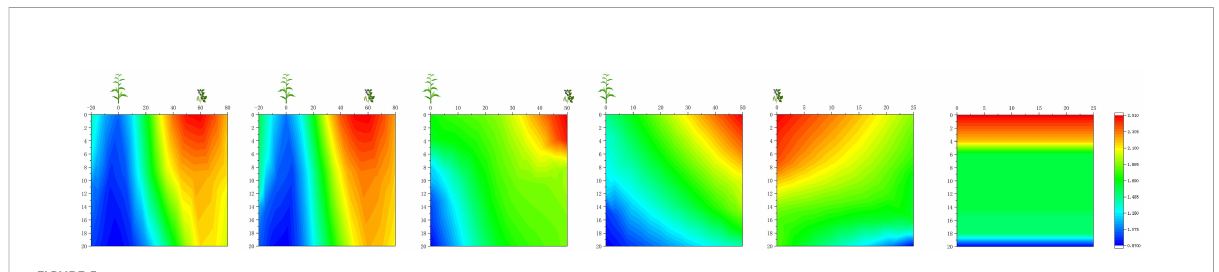
FIGURE 5 Spatial distribution of soil total nitrogen content under different planting patterns of maize and soybean. MS1, MS2, MS3, M, S, and FL represent the continuous planting of maize/soybean relay strip intercropping, planting of maize/soybean relay strip intercropping in rotation, traditional maize/soybean intercropping, sole maize planting, sole soybean planting, and fallow land, respectively.